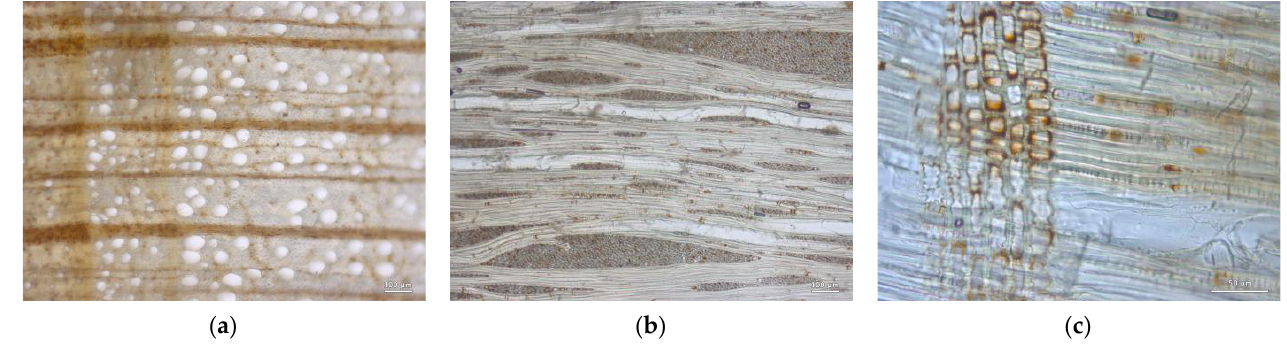
Figure 14. Characteristic sections of sample RI2 identified as belonging to the Fagus genus: ( a ) Cross- section; ( b ) Tangential section; ( c ) Radial section.